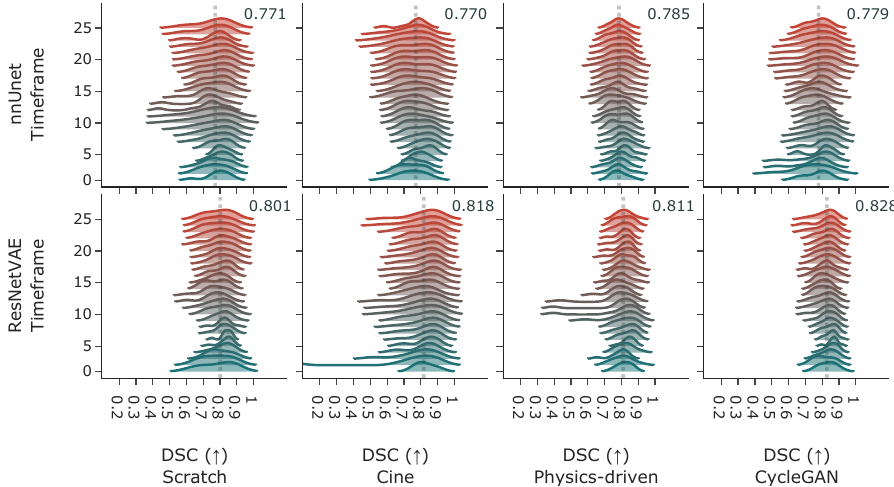
Figure 9. Dice coefficient performance metric distribution over the acquisition time-frames for nnUnet and ResNetVAE model architectures and different pretraining strategies (with cine images, simulated tagged with physics-driven transformation, and simulated tagged with CycleGAN transformation). The annotated dotted vertical line displays the average dice coefficient in each subplot. Time-point 1 is at ED and time-point 25 is at